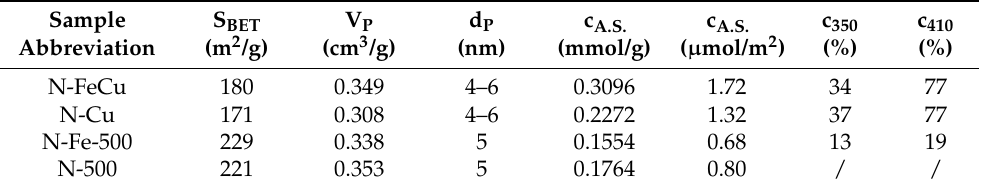
Table 1 shows textural and surface properties determined by nitrogen physisorp- tion (Supplementary Materials, Figure S2) and pyridine TPR (Supplementary Materials, Figure S3.1) together with catalytic activity (as percent of conversion) of the samples at 350 and 410 ◦ C. Decrease in specific surface area in Cu impregnated samples is noticed and expected due to the employed method of impregnation and the second calcination that follows. During that, also the pore diameter gets broader, from 5 nm to 4–6 nm in comparison to those without and with copper. An interesting observation is the acid site concentration decrease, when iron is introduced, from 0.8 to 0.68 µ mol/m 2 , compensating the Lewis acidity of alumina after impregnation with copper, acid site concentration was significantly increased to 1.32 µ mol/m 2 in case of sample without iron and to 1.72 µ mol/m 2 when iron was present in the sample. Slightly stronger acid sites were present in “N-Cu” sample compared to the “N-FeCu” sample in the low temperature range below 300 ◦ C (see Supplementary Materials, Figure S3.2). Table 1. Brunauer-Emmett-Teller (BET) specific surface area (S BET ), pore volume (V p ), pore diameter (d P ), concentration of acid sites (c A.S. ) and conversion of toluene at 350 (c 350 ) and 410 ◦ C (c 410 ) (based on catalytic activity presented in chapter Catalytic properties) of “N-500”, “N-Fe-500”, “N-Cu” and “N-FeCu” samples.